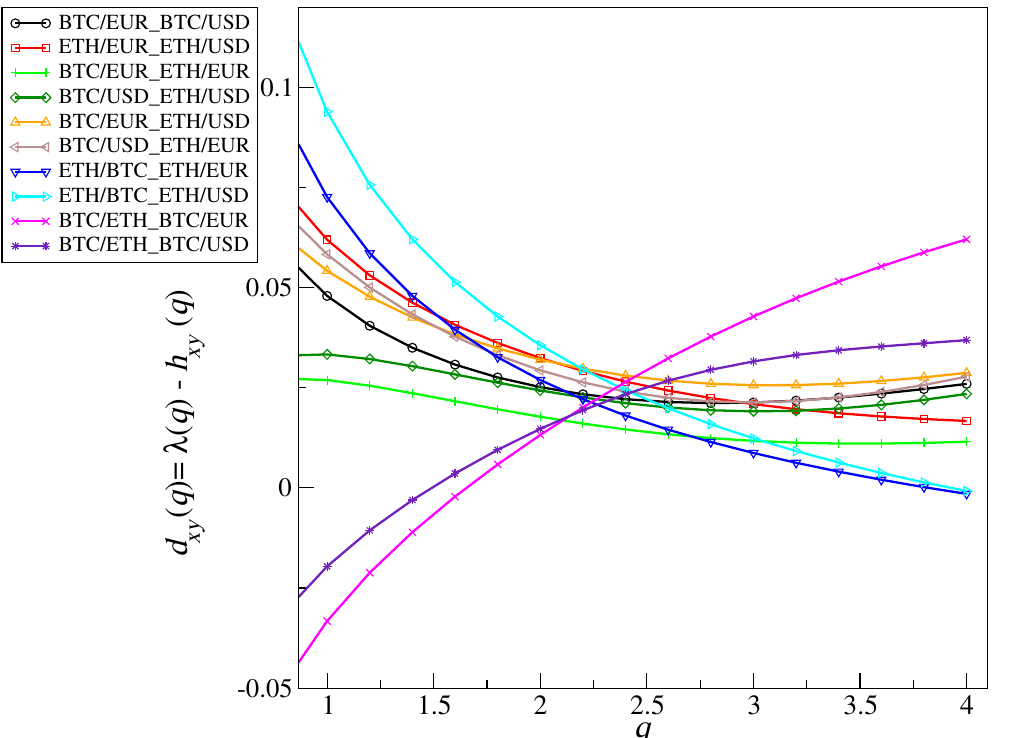
Figure 9. (Color online) Differences between multifractal cross-correlation scaling exponents λ ( q ) and the average generalized Hurst exponents h xy ( q ) estimated for q ∈ [ 1,4 ] corresponding to the cases considered in Figure